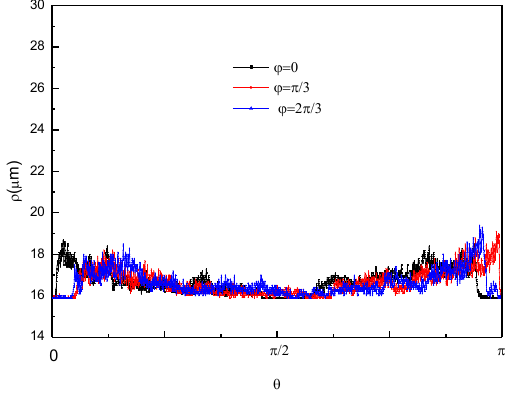
Figure 12. Radius of curvature ( ρ ) in relation to the scanned path ( L ) with longitude ϕ = 0, π / 3, and 2 π / 3, respectively. Table 2. Statistics (mean, standard deviation, minimum, median, and maximum) for the radius of curvature, calculated by Origin